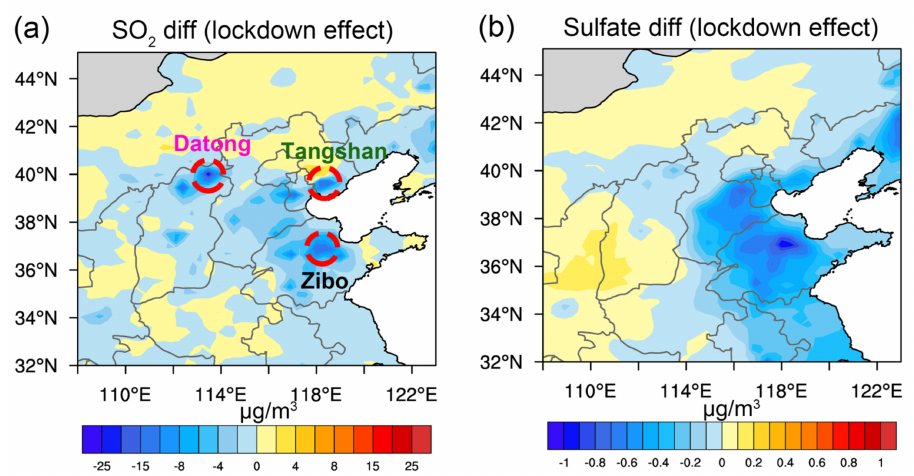
Figure 6. The difference in the surface distributions of ( a ) SO 2 and ( b ) sulfate concentrations between the pre-lockdown and lockdown periods (lockdown minus pre-lockdown; units: µ g/m 3 ). The red dotted circles mark the location of Datong, Tangshan, and Zibo city.